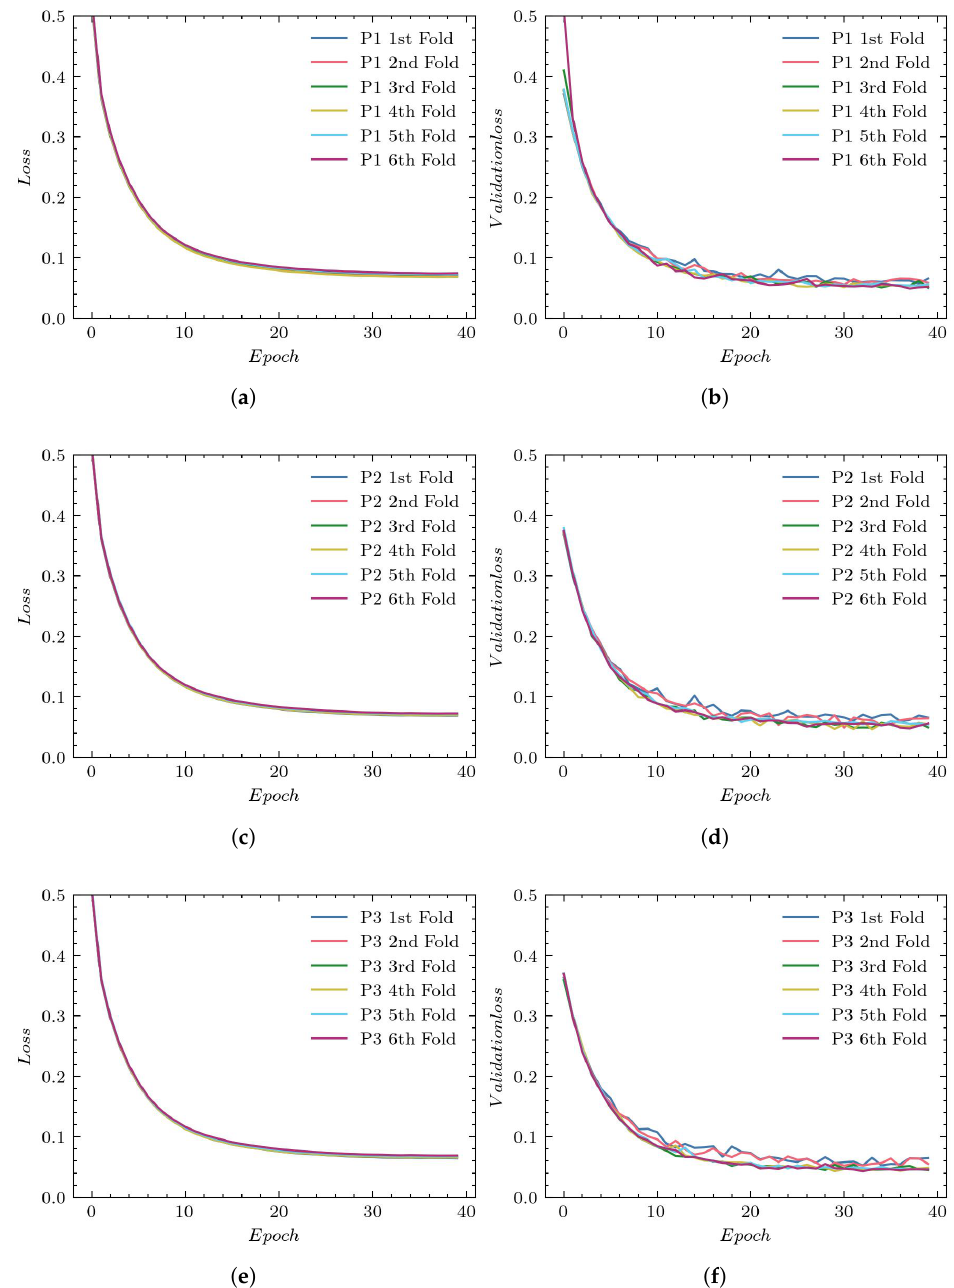
Figure 13. Loss plots for FR-UNet architecture: ( a ) training using P1, ( b ) validation using P1, ( c ) training using P2, ( d ) validation using P2, ( e ) training using P3, and ( f ) validation using